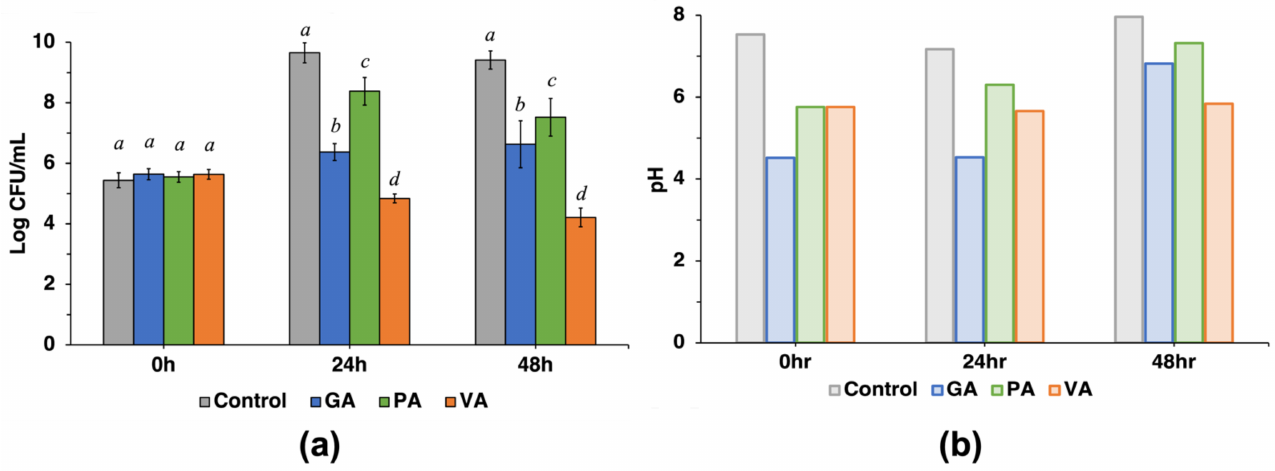
Figure 1. Antimicrobial effect of gallic acid (GA), protocatechuic acid (PA), and vanillic acid (VA) on Salmonella enterica serovar Typhimurium (ST) in cecum fluid conditions measured in Log CFU/mL at the 0 h, 24 h, and 48 h timepoints ( a ), while pH was measured at the same timepoints at which sample aliquots were taken ( b ). Statistically significant ( p < 0.05) values between treatments when compared to the untreated control at the respective timepoints are denoted with letters a–d